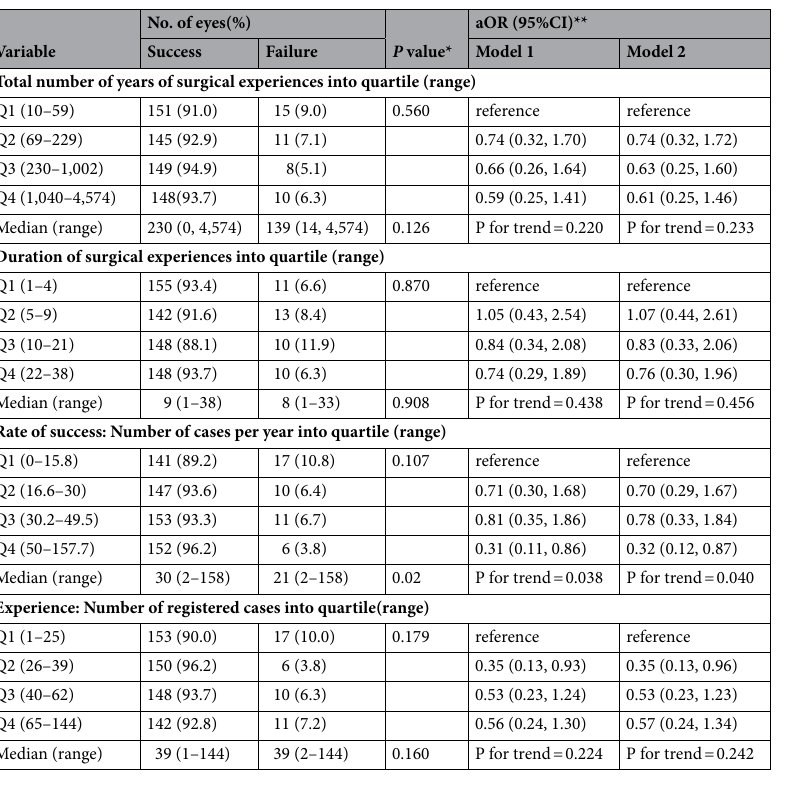
Table 2. Relationship in SB cases between factors associated with surgeons’ experience and surgical outcomes. SB, scleral buckling; aOR, adjusted odds ratio; CI, confidence interval. *Chi-square test or Mann–Whitney